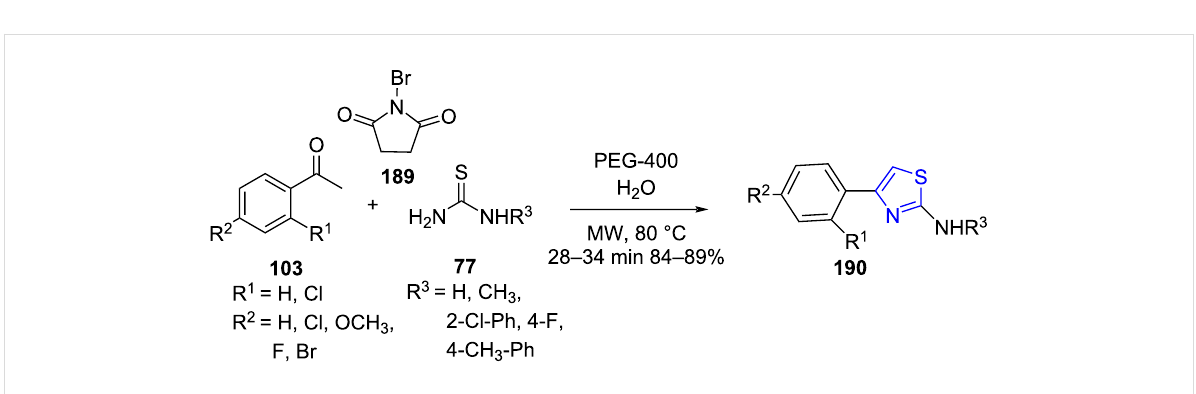
Figure 14: Thiazole containing drugs.